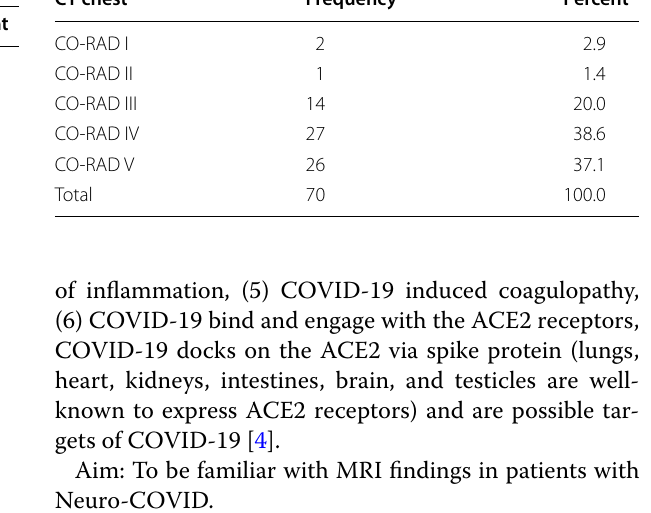
Table 2 The frequency of comorbidity and neurological manifestations in patients with COVID-19